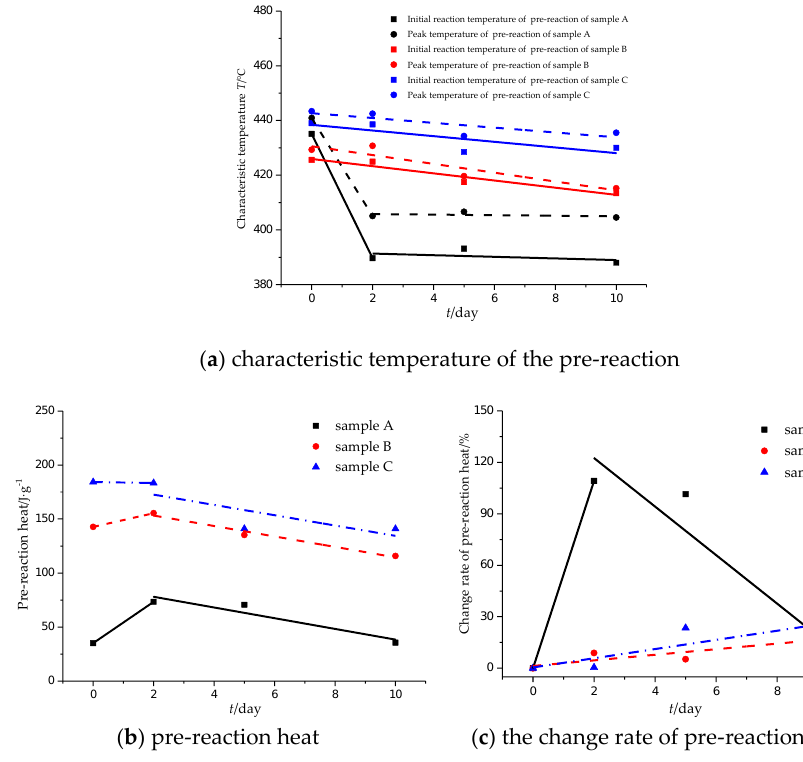
Figure 10. Characteristic parameters of the DSC curve of the pre-reaction.